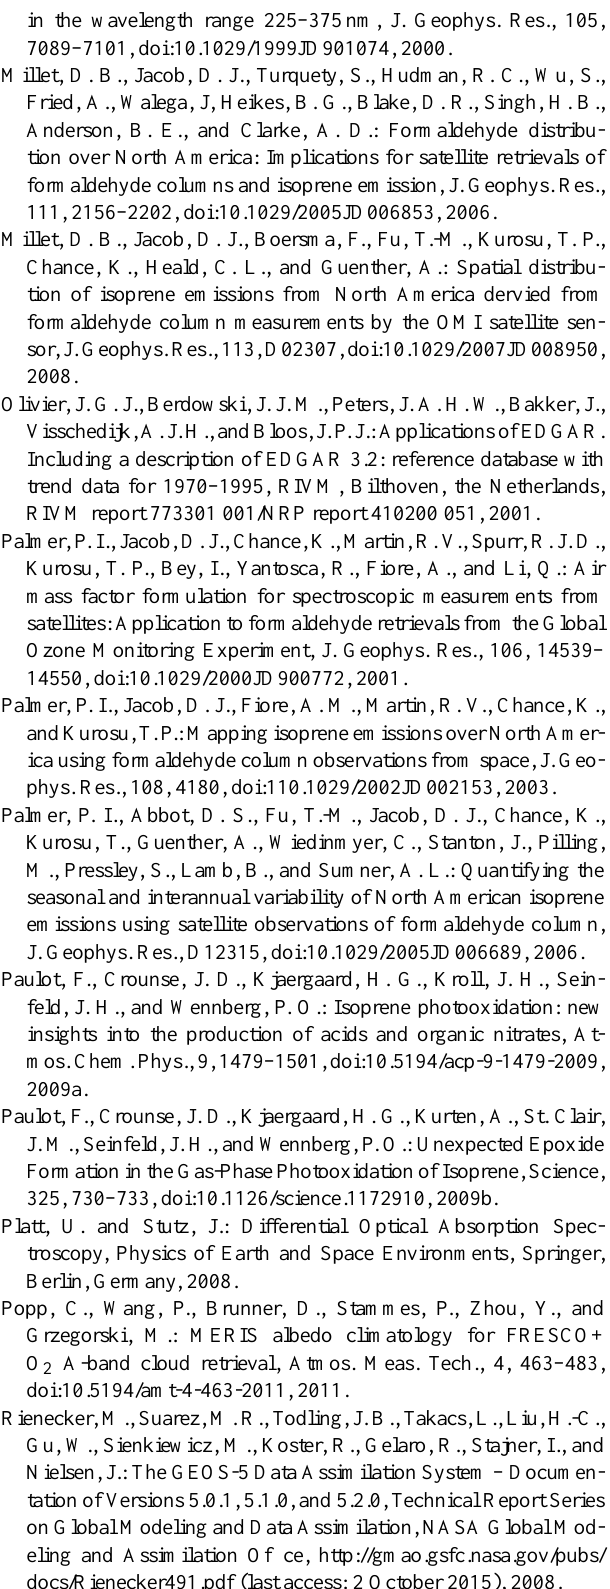
Algorithm Theoretical Basis Document for GOME-2 Total Column Products of Ozone, NO 2 , tropospheric NO 2 ,